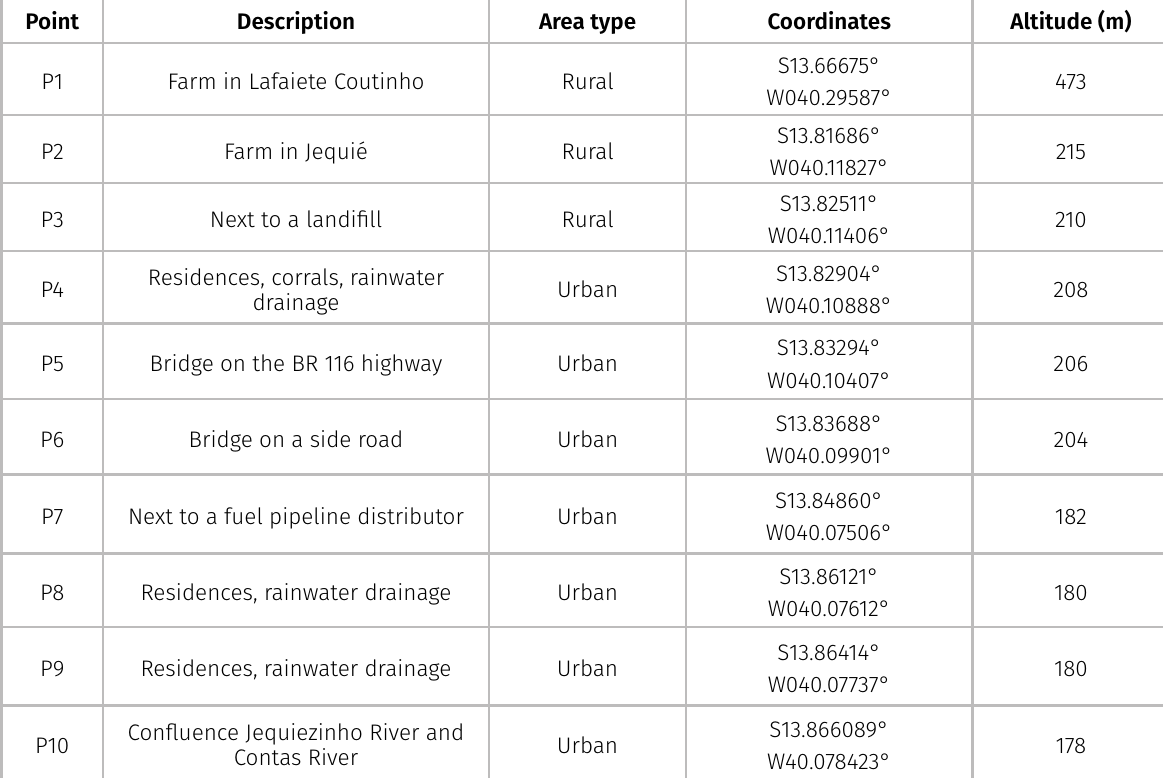
Table I. Location/characterization of collection points of sediments.